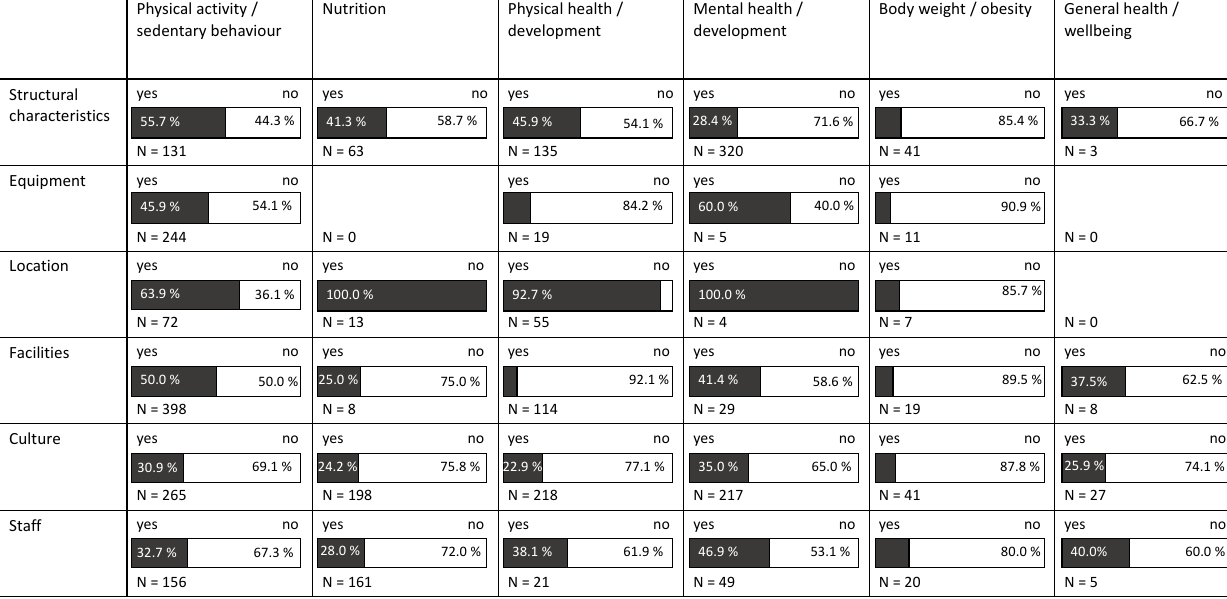
Figure 4. Associations between ECEC center MLCs with health, health behavior, and wellbeing of children.